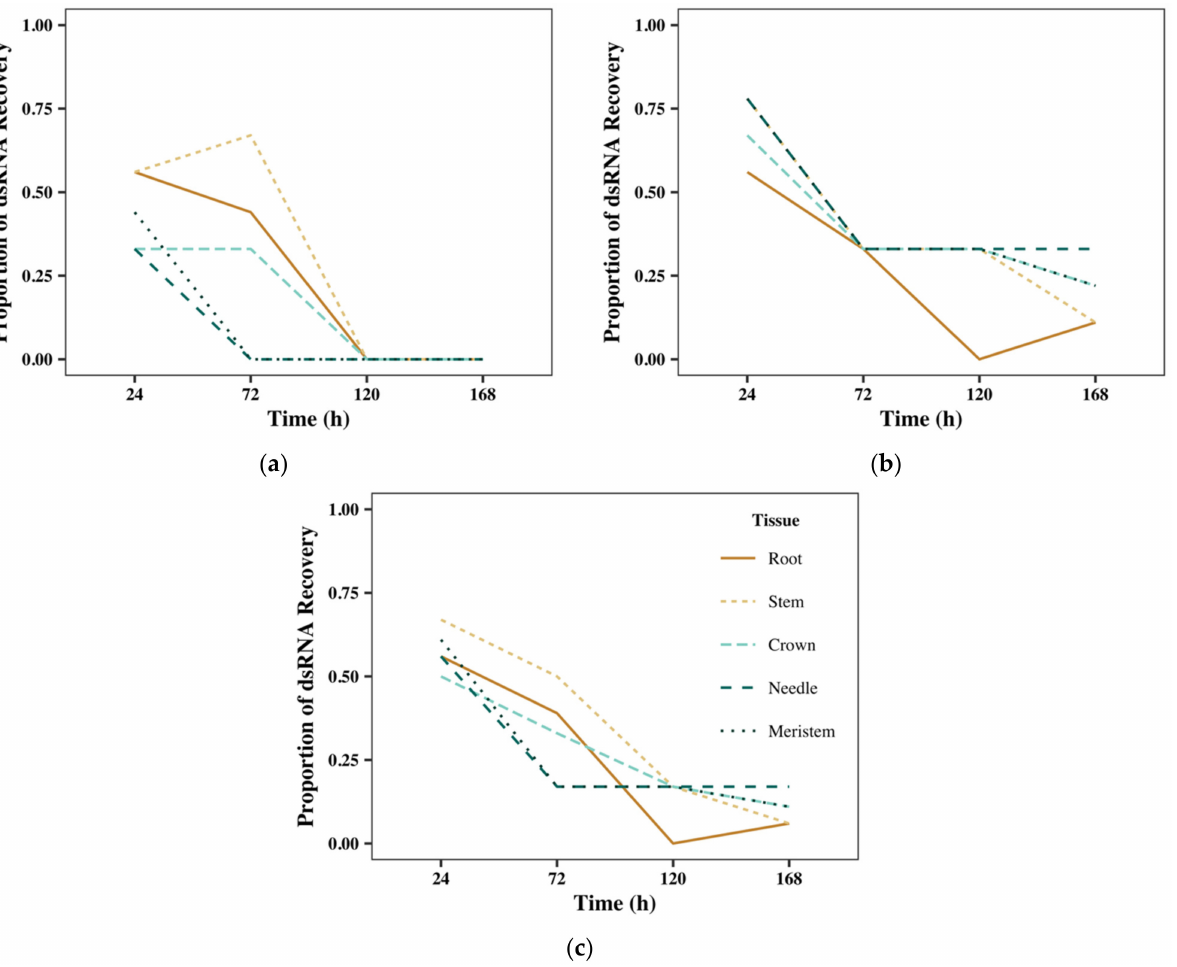
Figure 3. The proportional success of dsRNA recovery in loblolly pine tissues showing ( a ) combined dsSHI and dsGFP recovery, and the recovery of ( b ) only dsSHI, and ( c ) only dsGFP across replicates. Across all replicates, dsGFP was recovered from all five tissue types and present in all time points for 7 days. In contrast, dsSHI was recovered from each tissue type but only through the first 3 days. Collectively, seedlings in rep 1 had more instances of dsRNA recovery in both treatment groups when compared to the other two replicates (Table S1). The differences between replicates were less drastic with dsSHI, where both reps 1 and 2 showed successful recovery of dsRNA at 1 and 3 days but none at 5 or 7 days and rep 3 showed a total lack of dsRNA recovery at all four time points. In contrast, in rep 1, dsGFP was recovered from seedlings at all four time points, but only recovered at one day in reps 2 and